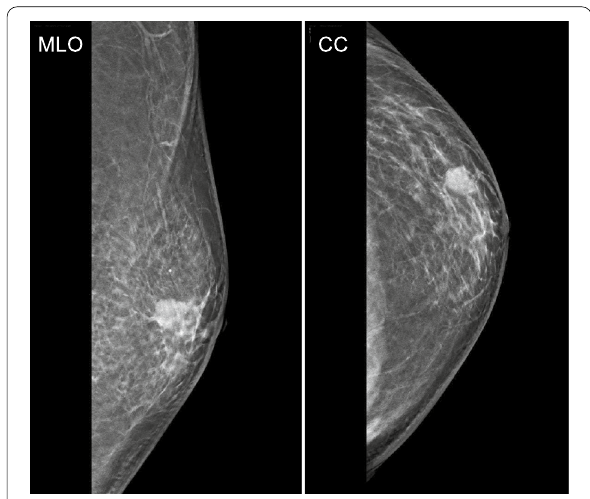
Fig. 2 Mammographic findings showing a well-defined mass in the patient’s left breast. Note that MLO denotes medio-lateral-oblique and CC denotes